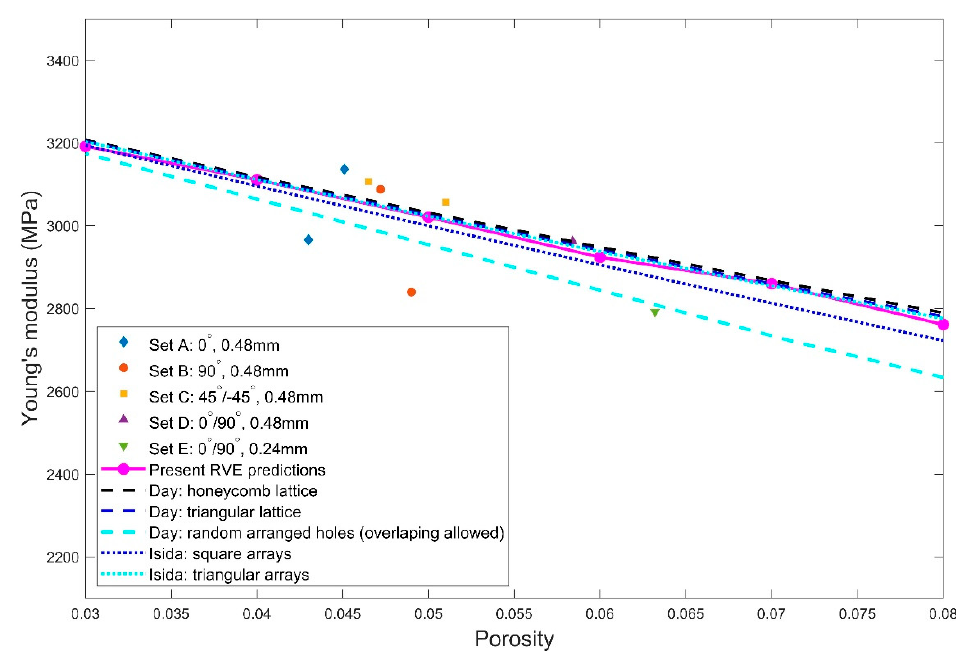
Figure 16. Comparison of the predicted Young’s modulus with the experimental data against porosity for the five sets of specimens (with various combinations of raster orientations and extrusion widths). The results from the existing numerical models in [35] and [36] are also included for reference.